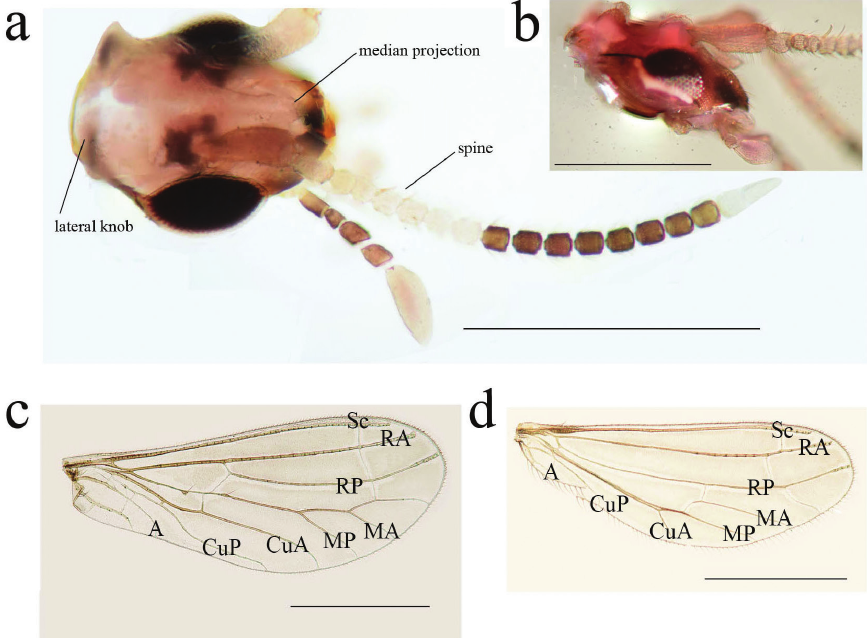
Figure 5. Heteroconis yunnanensis sp. nov., holotype male a habitus, lateral view b head, dorsal view c forewing d hindwing. Scale bar: 1